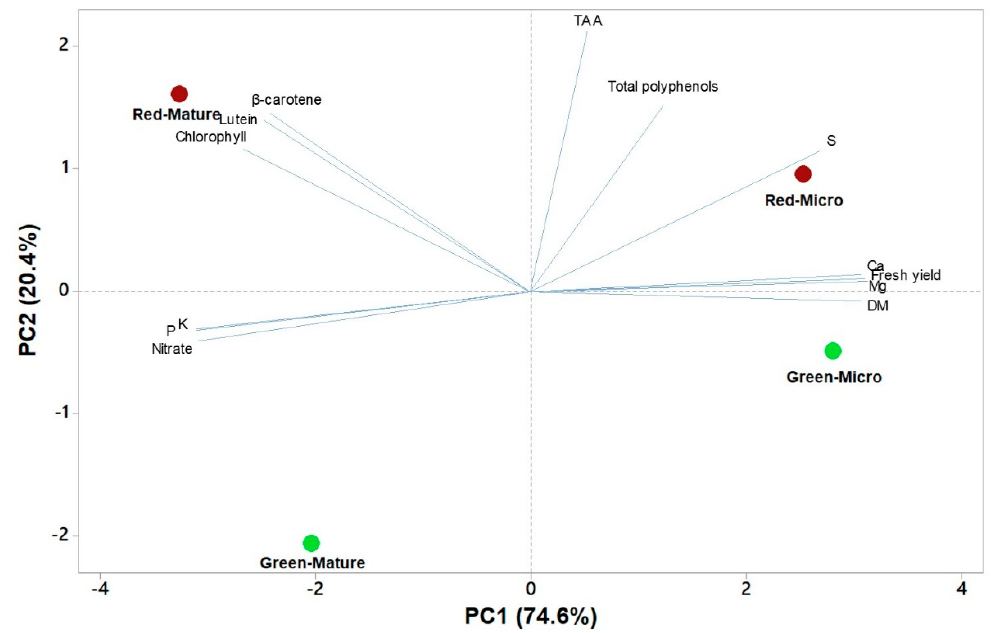
Figure 2. Principal component loading plot and scores of principal component analysis (PCA) of fresh yield, dry matter percentage (DM), macromineral (K, Ca, Mg, P, S and nitrate), chlorophyll, carotenoids (lutein and β -carotene) and total polyphenols in green and red microgreens and mature leaves of Salanova lettuce.